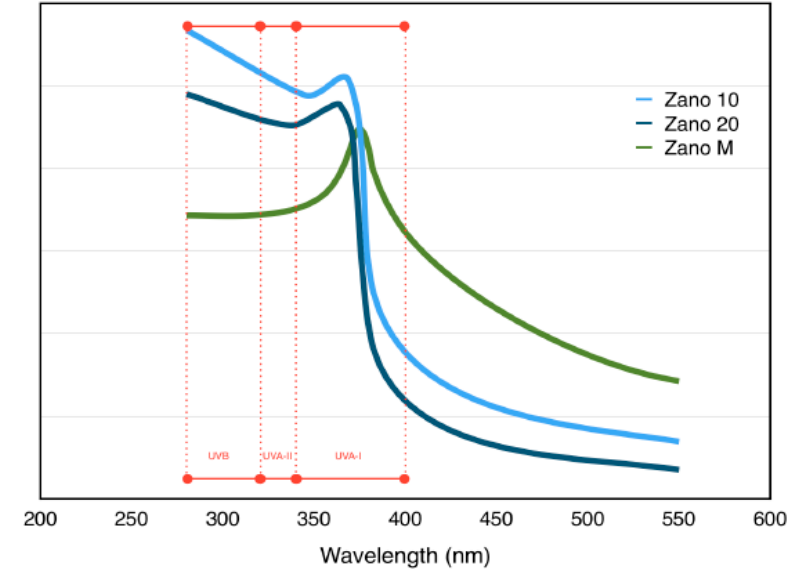
Figure 10. UV/VIS absorbance curves of a solution 0.1% of ZnO (Zano, courtesy from EVERZINC group SA, Liege, Belgium) particles of different dimension in caprylic/capric triglyceride.